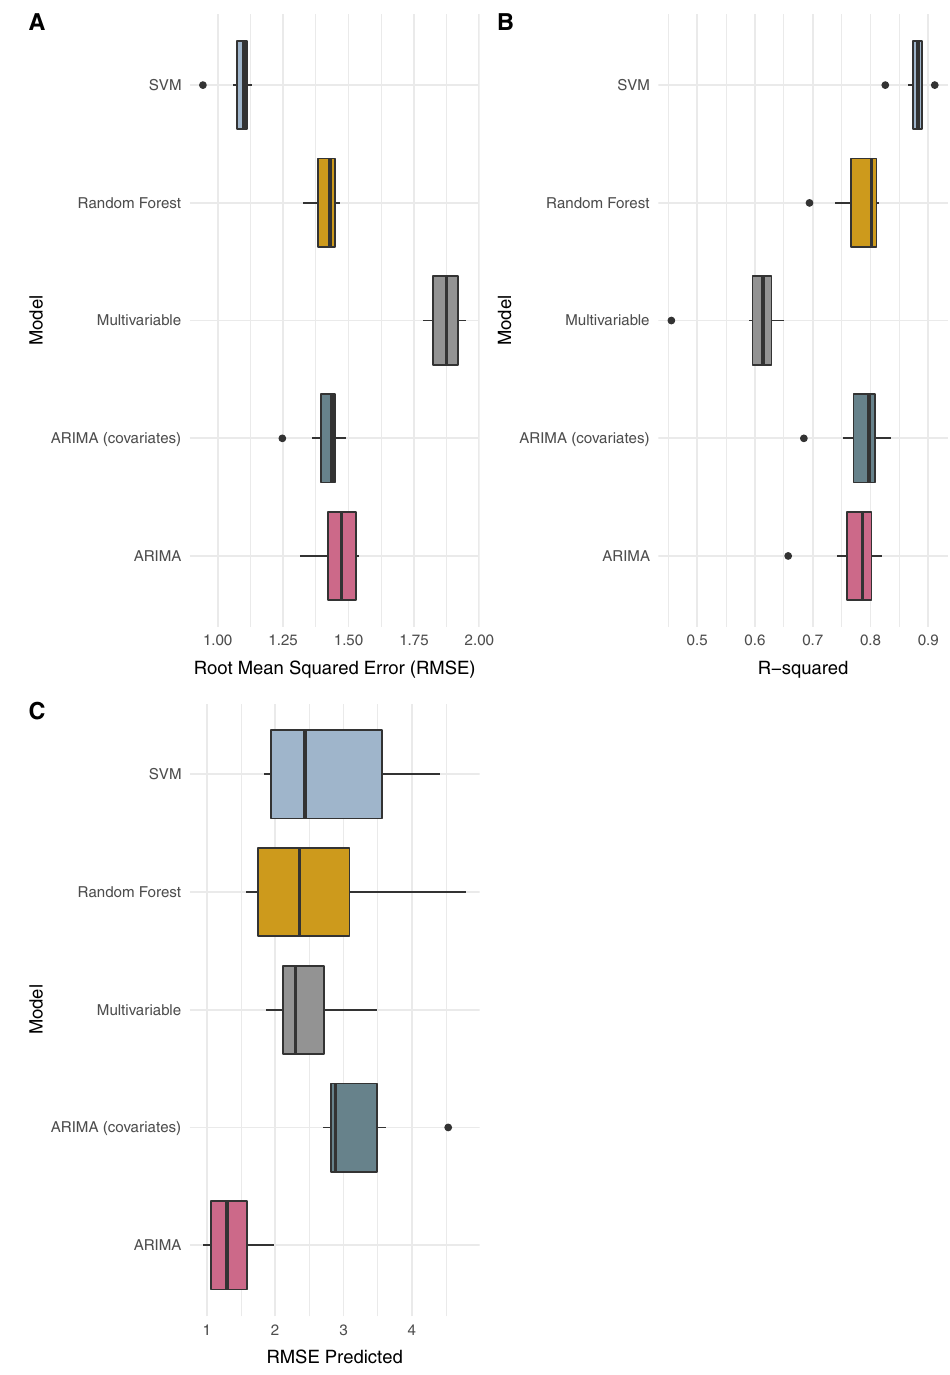
Figure 2. Comparison of models at the national level. (A) Root Mean Squared Error (RMSE) of fitted values, (B) model R-squared and (C) RMSE of out-of-sample predictions. The models are Support Vector Machines Regression (SVM), Random Forest Regression, Multivariable linear regression, and ARIMA with [i.e., ARIMA (covariates)] and without (i.e., ARIMA) search data as explanatory